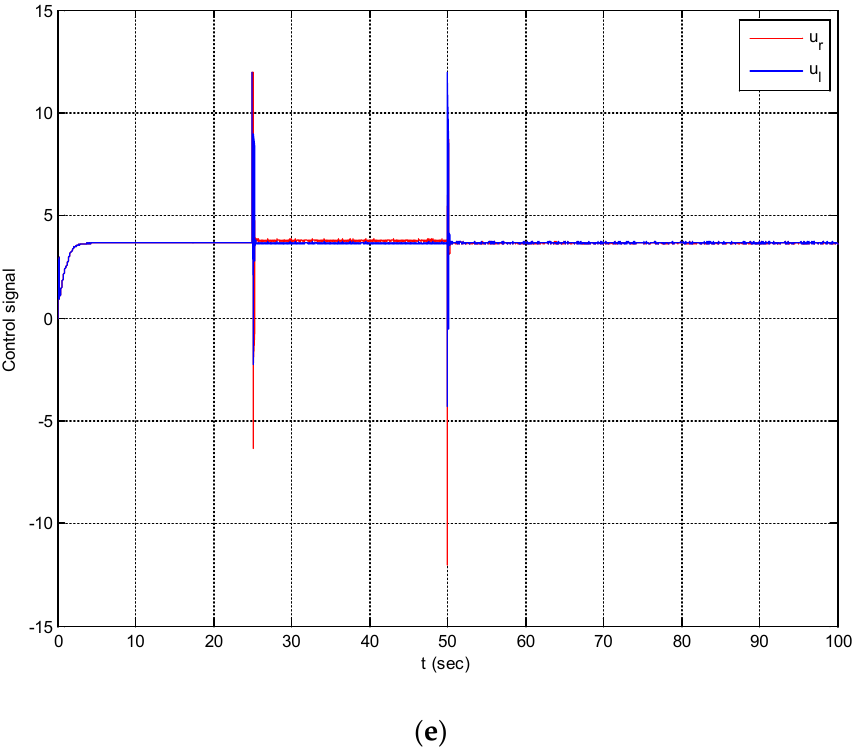
Figure 8. Output results for SMHOESO, ( a ) the right wheel angular velocity, ( b ) close-up of ( a ), ( c ) the left wheel angular velocity, ( d ) the orientation error of the DDMR, and ( e ) the control signal. The kinematic index (see Table 5) for the ADRC based on SMHOESO significantly improved as compared to the traditional ADRC, with an OPI θ reduction of 99.3447%. The simulations (see Table 6) demonstrate that, in contrast to a discernible improvement in the transient response, the ISU, which indicates the energy given to the PMDC motor, has unintentionally increased. In addition, the suggested observer almost eliminates the chattering in the control signal brought on by Han’s traditional ADRC. Table 5. The DDMR kinematics index.